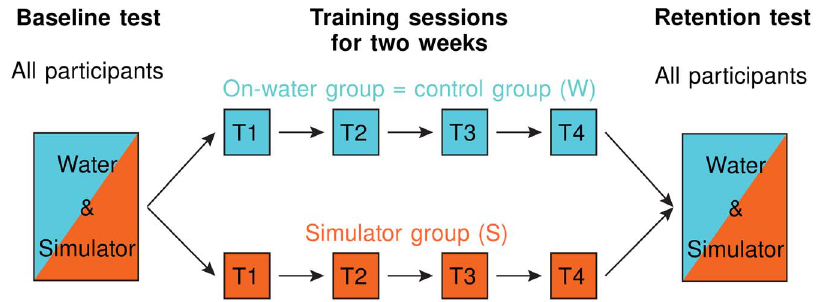
Figure 10. Study design for the two participant groups. Group 1 (on-water group=control group) trained on water ( cyan ) and group 2 (simulator group) in the simulator ( orange ). Before the training started, all participants underwent a baseline test under both conditions: in the simulator and on water. Then, both groups trained under their according condition for two weeks. During these two weeks, all participants trained four times under supervision of the same rowing trainer. Finally, both groups underwent a retention test similar to the baseline